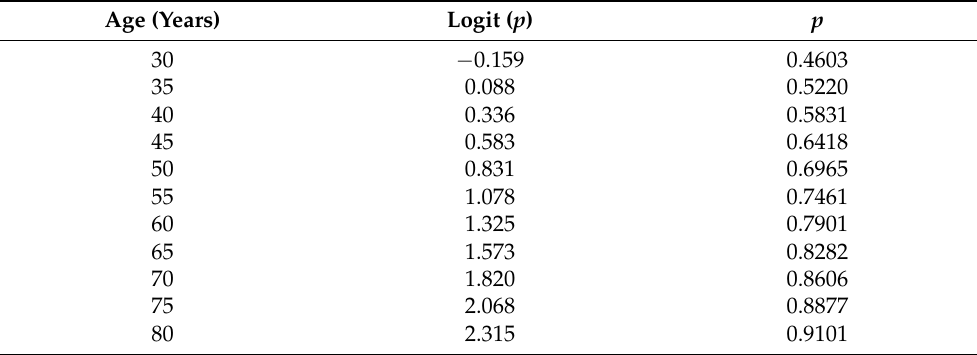
Table 6. The risk of mortality in a non-dialysis male patient.